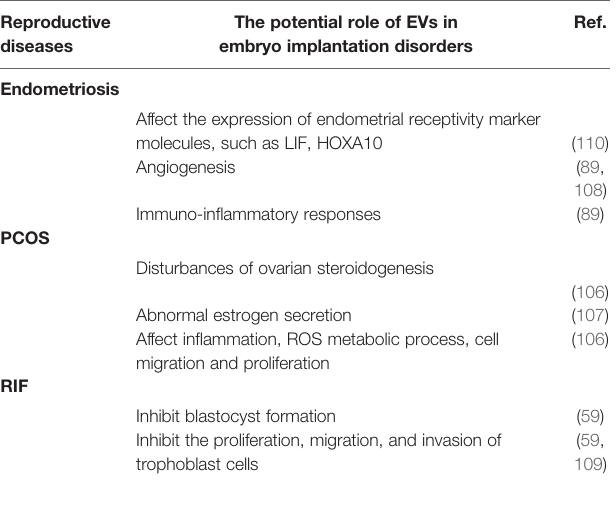
TABLE 3 | EVs in reproductive diseases and their potential roles in embryo implantation disorders. Reproductive